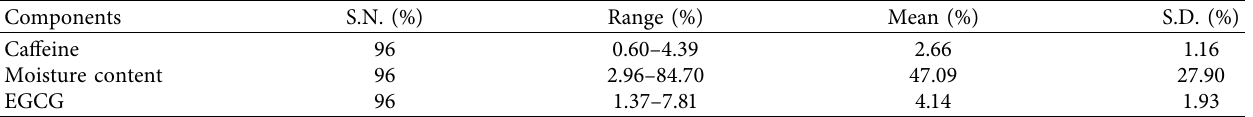
Figure 6: Original NIR spectra (a) and pretreated NIR spectra (b) of green tea samples. Table 1: Reference measurements and the number of samples in the training group.